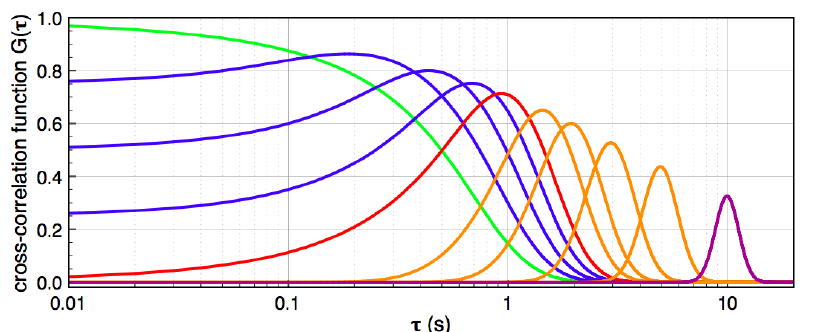
Figure 7. Analytical correlation functions for a varying separation distance in 100 μm. Green curve: Autocorrelation, which corresponds to ; blue curves: intermediate auto-cross-correlation for a gap length = −75 μm, −50 μm, −25 μm; red, orange, purple curves: cross-correlation with = 0 μm…1000